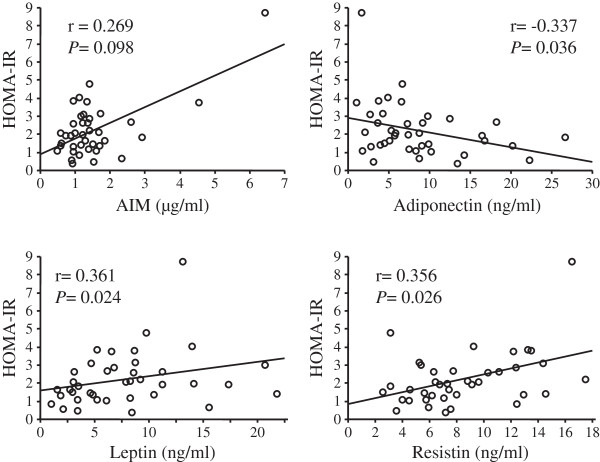
Correlation between serum levels of AIM, adiponectin, leptin, or resistin and HOMA-IR. Resistin and leptin levels were positively and serum adiponectin levels were negatively correlated with HOMA-IR. There was a tendency towards a positive correlation between serum AIM levels and HOMA-IR. AIM, apoptosis inhibitor of macrophage; HOMA-IR, homeostasis model assessment-insulin resistance. Correlation coefficients were calculated by Spearman’s rank correlation analysis.